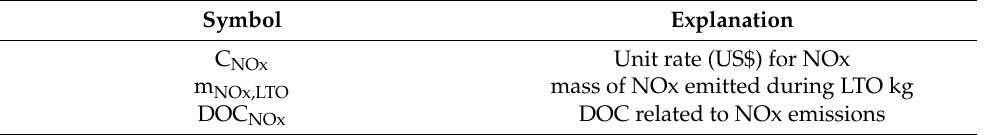
Table 9. Emission cost symbols